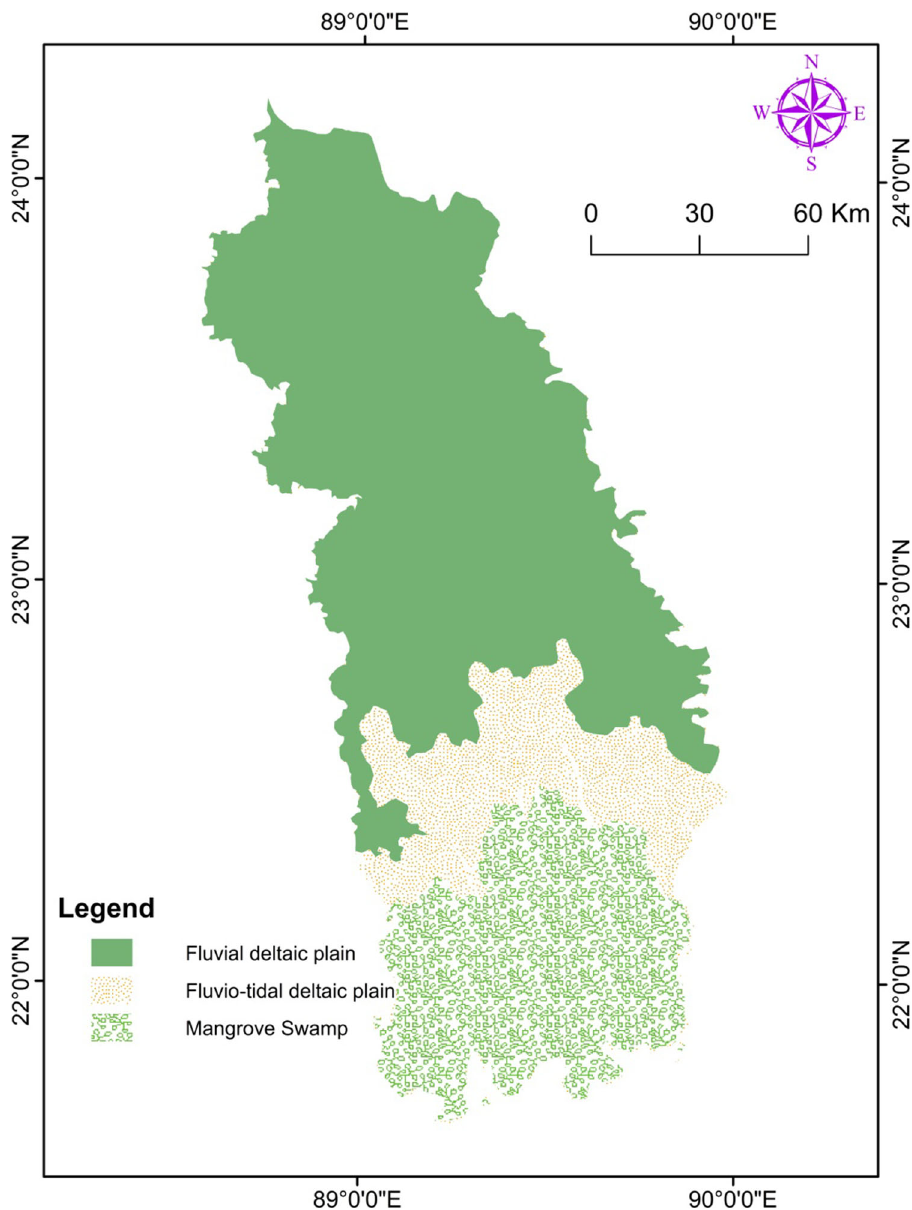
Fig. 3 Major geomorphic units of the